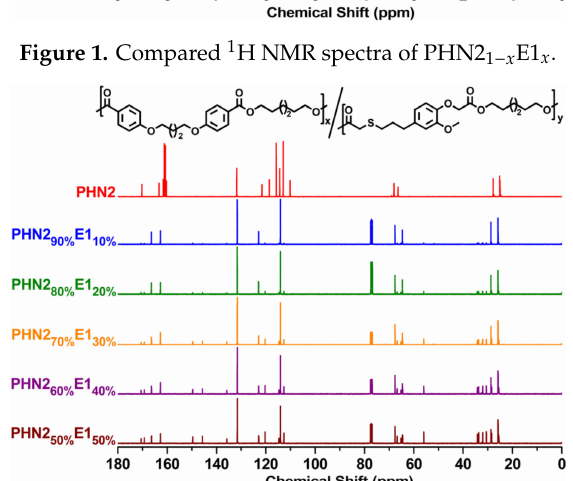
Figure 2. Compared 13 C NMR spectra of PHN2 1 − x E1 x